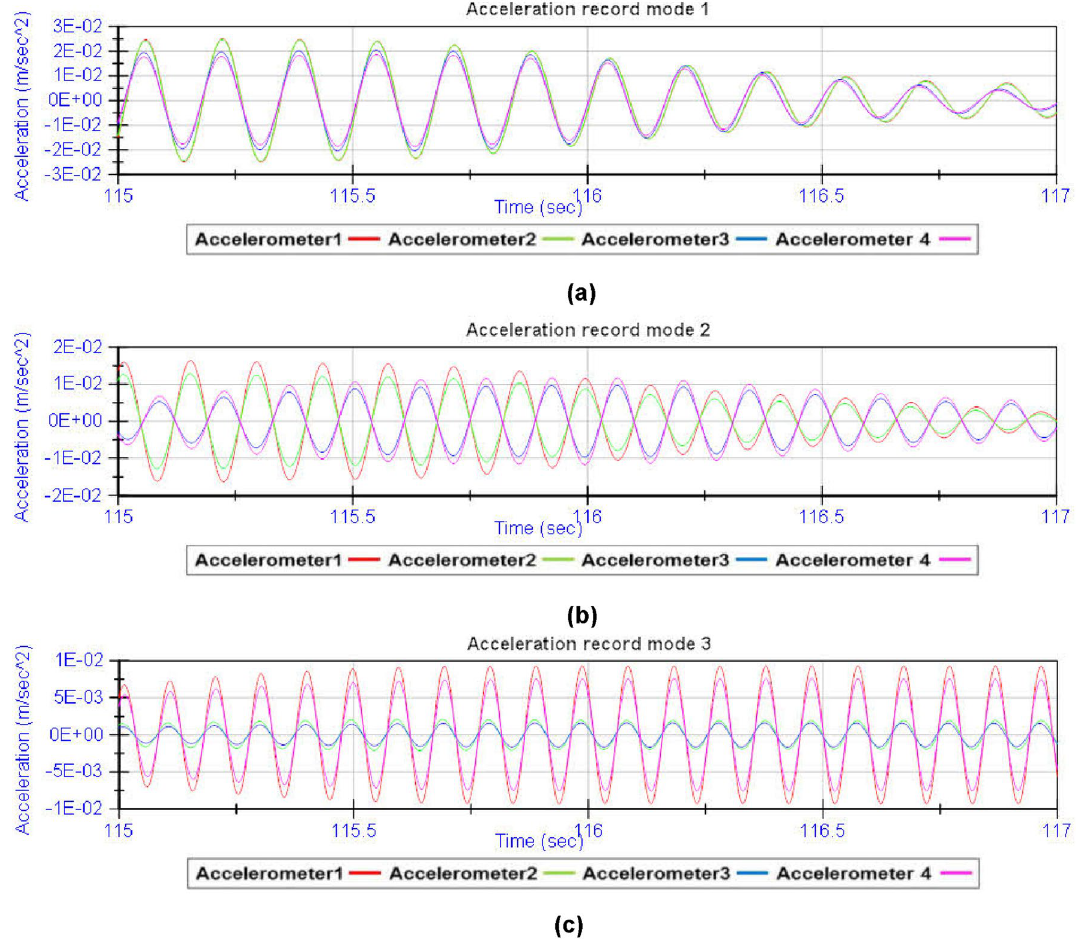
Figure 14. Spectral decomposition: ( a ) acceleration associated with vibration mode 1; ( b ) acceleration associated with vibration mode 2; ( c ) acceleration associated with vibration mode